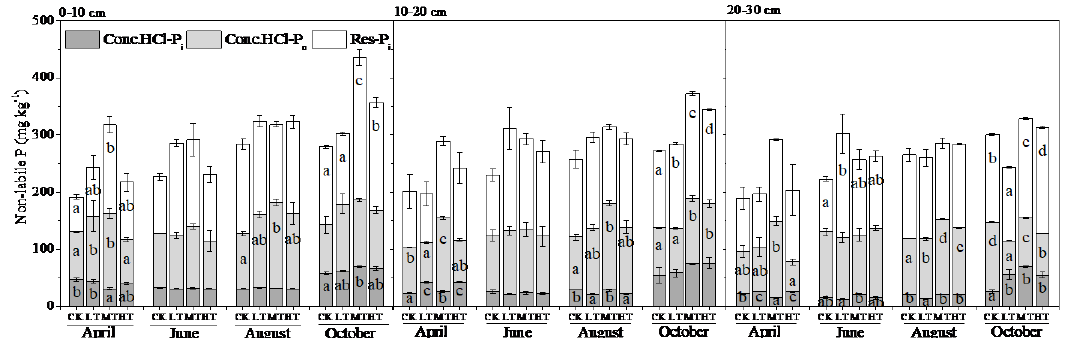
Figure 6. Response of non-labile P fractions to thinning treatments at the three depths (0 − 10, 10 − 20 and 20 − 30 cm) at various sampling times in L. principis-rupprechtii plantations. CK, control site; LT, light thinning; MT, moderate thinning; HT, high thinning. Error bars indicate standard error ( n = 3). Values within each sampling time followed by different letters differ significantly according to Tukey’s test ( p < 0.05). When the difference was not statistically significant, no letter notation was noted.